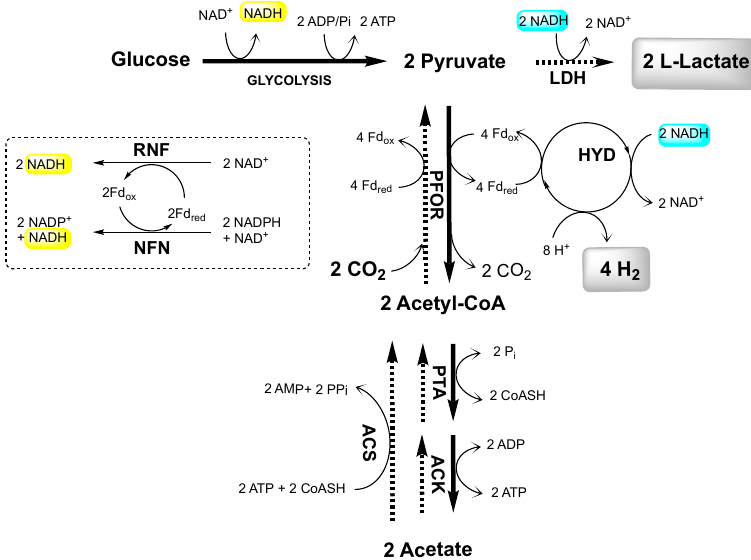
Figure 1. Schematic proposal of the CLF pathway in T. neapolitana. ACK, acetate kinase; PTA, phosphotransacetylase; ACS, acetyl-CoA synthetase; PFOR, pyruvate:ferredoxin oxidoreductase; LDH, lactate dehydrogenase; HYD, hydrogenase; RNF, NAD-ferredoxin oxidoreductase; NFN, NADH-dependent reduced ferredoxin:NADP oxidoreductase; Fd, ferredoxin. NADH-source reactions in yellow; NADH-consuming reactions in turquoise. Protons are omitted in the REDOX reactions.